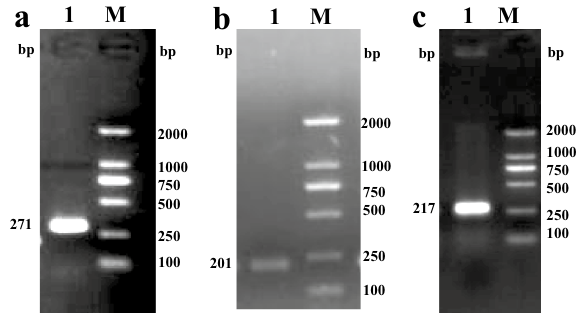
Figure 1. Amplification of a candidate hirudin gene from the salivary gland transcriptome of Hirudo nipponia . ( a ) Intermediate fragment amplification. ( b ) 5 ′ -rapid amplification of cDNA ends (RACE) amplification. ( c ) 3 ′ -RACE amplification (1: Target fragment; M: Marker DL2000). The polymerase chain reaction (PCR) products were analyzed on a 1% agarose gel. The original gel is presented in Fig.